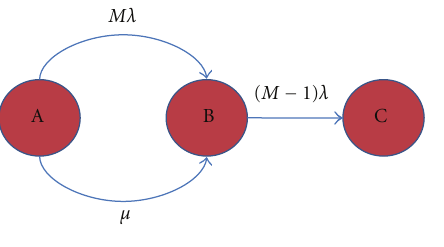
Figure 25: A Markov reliability model for a MIN with repair.